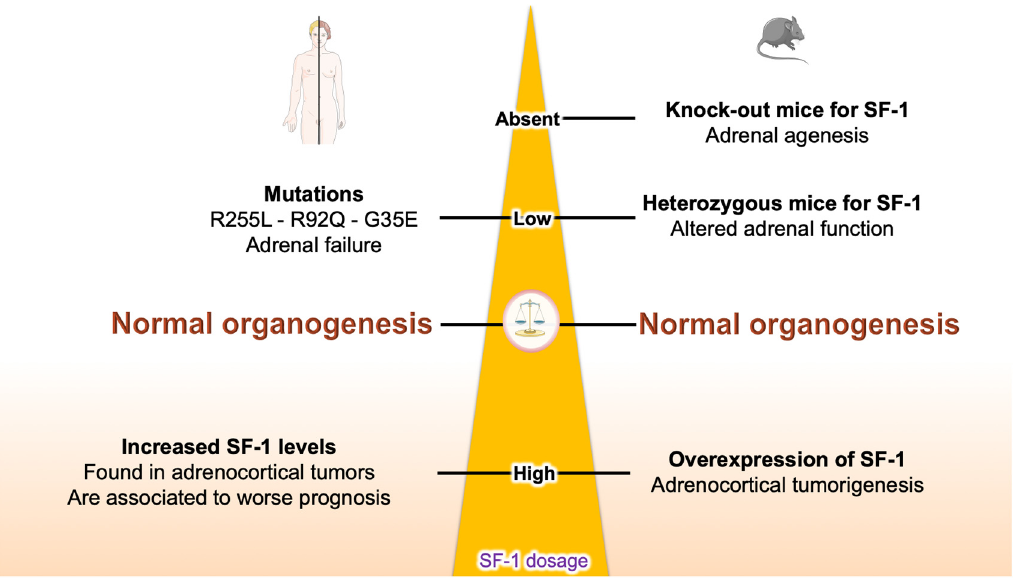
Figure 3. Adrenal phenotypes associated with an altered SF-1 dosage in mice and